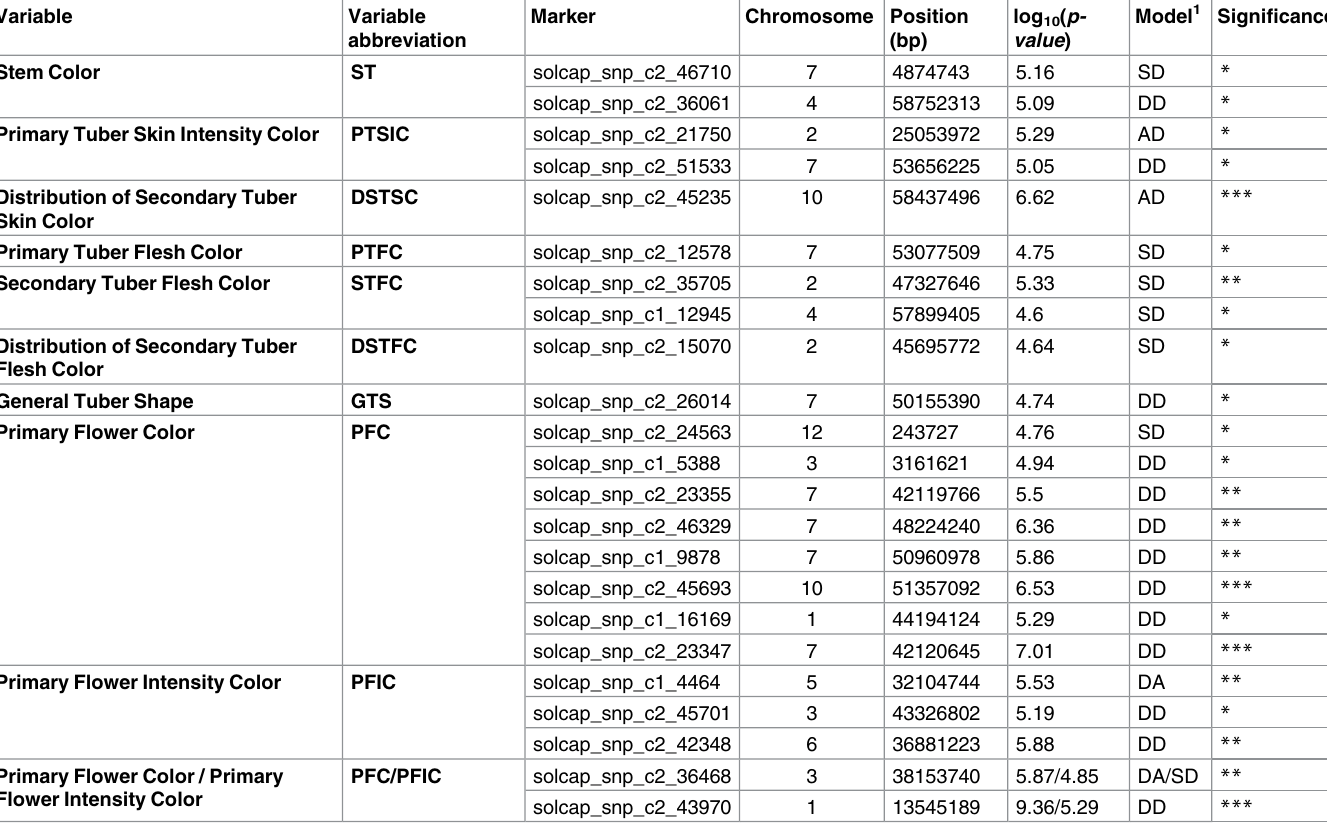
Table 7. List of SNPs associated to qualitative data in tetraploid accessions of S . tuberosum of the Colombian Central Collection.